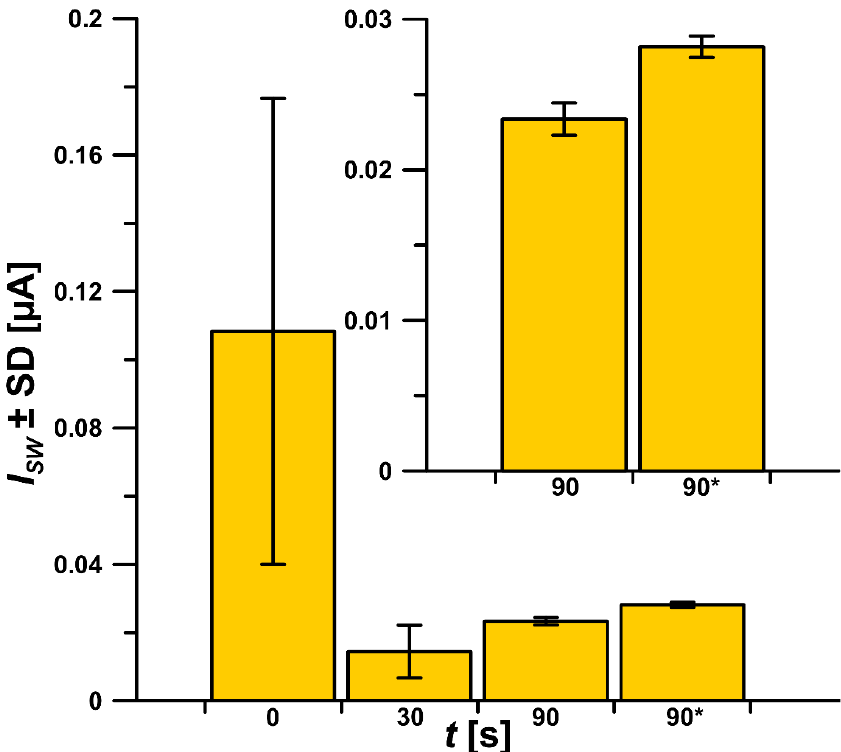
Figure 6. The relationship between I SW and t (CTAB and ROX accumulation time). * means time without stirring the solution. The standard deviation was calculated for n = 3.